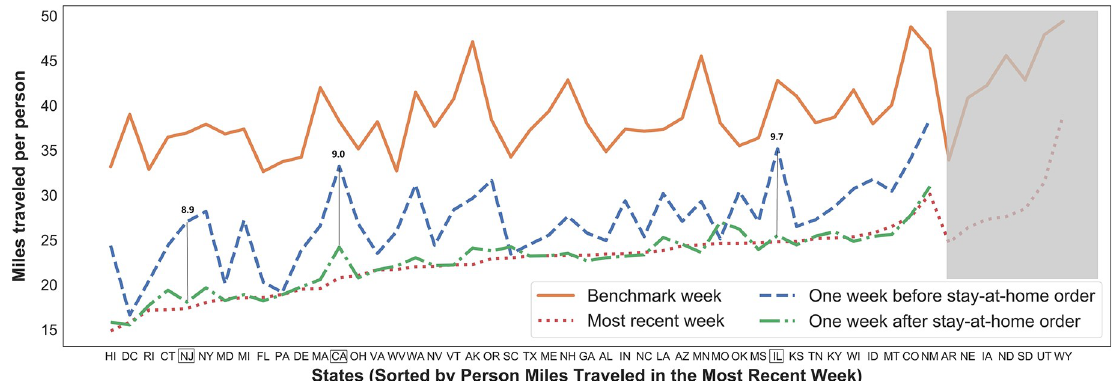
Fig 4. Statewide trends on miles traveled per person.